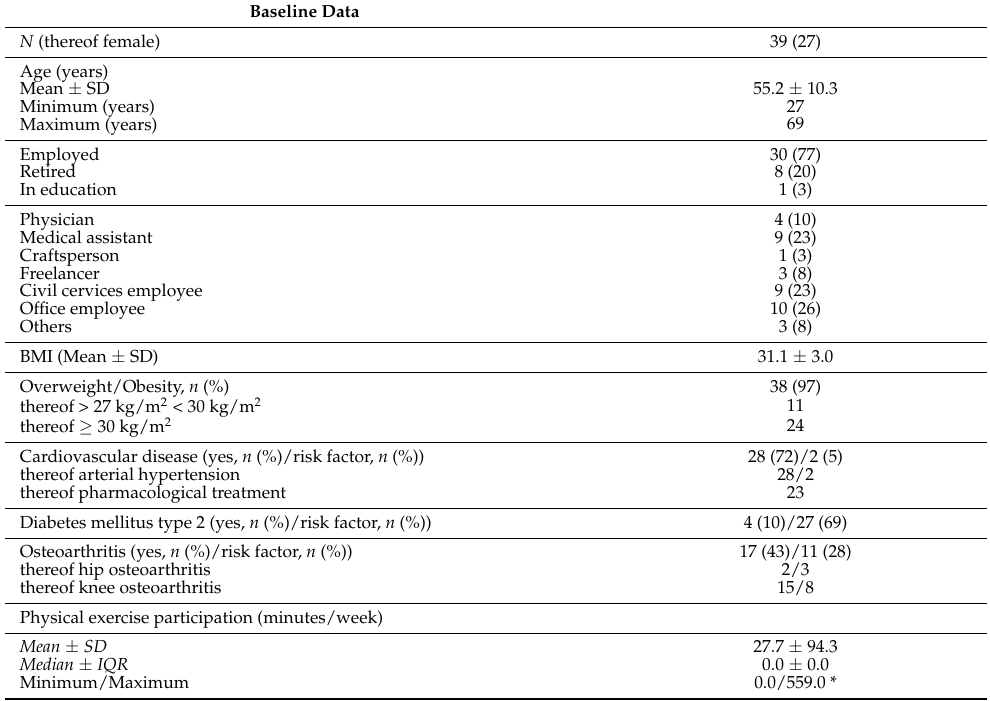
Table 2. Participants’ characteristics at baseline including demographics and prevalence of chronic diseases including the total sample ( n =